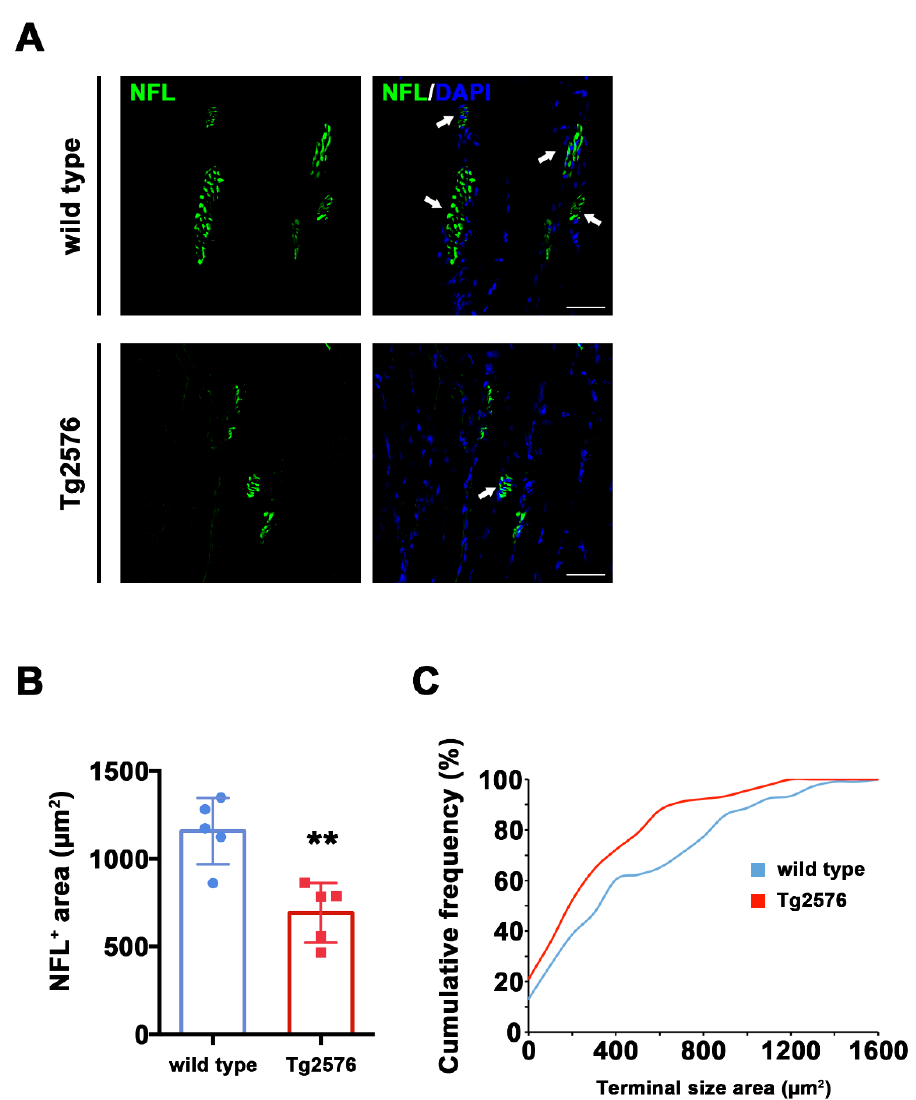
Figure 2. Reduced pre-synaptic area in TA muscle of Tg2576 mice. ( A ) Representative images of TA sections, stained with antibodies anti-NFL (green) from Tg2576 and wild type mice. Sections were counterstained with DAPI in order to detect cell nuclei. White arrows point to pre-synaptic area. Scale bar = 50 µ m. ( B ) Histogram reporting the average area of NFL signal in pre-synaptic areas from TA sections of Tg2576 and wild type mice ( n = 5 mice per genotype). Unpaired t test was used for comparison (** = p < 0.01). ( C ) Graph of cumulative frequencies reporting the distribution of NFL-positive signal sizes of both genotypes ( n = 5 mice per genotype). Kolmogorov–Smirnov test was used for comparisons ( p <